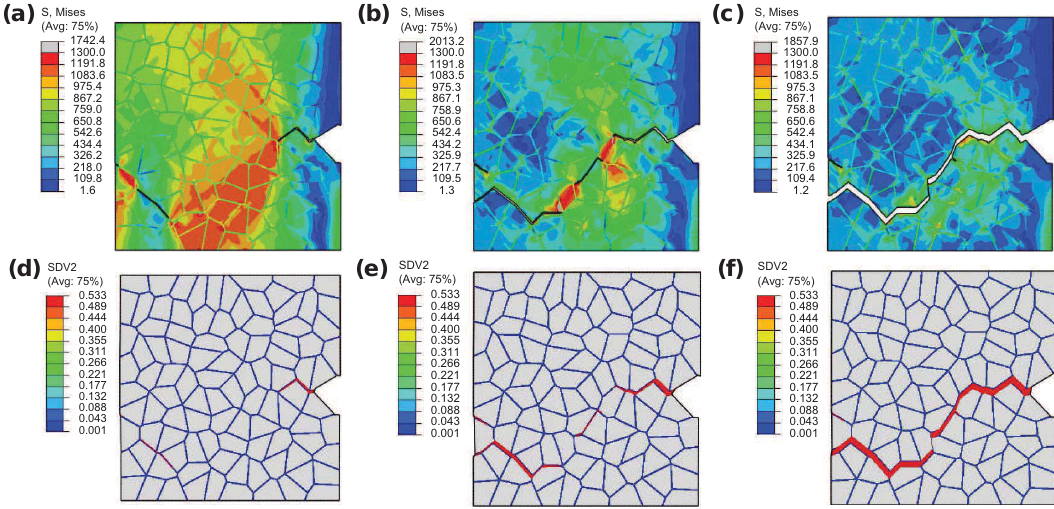
Figure 9. Contour maps during intergranular crack propagation: ( a – c ) von Mises stress; ( d – f ) damage evolution. The imposed displacement is ( a , d ) 0.04 mm; ( b , e ) 0.08 mm; ( c , f ) 0.3